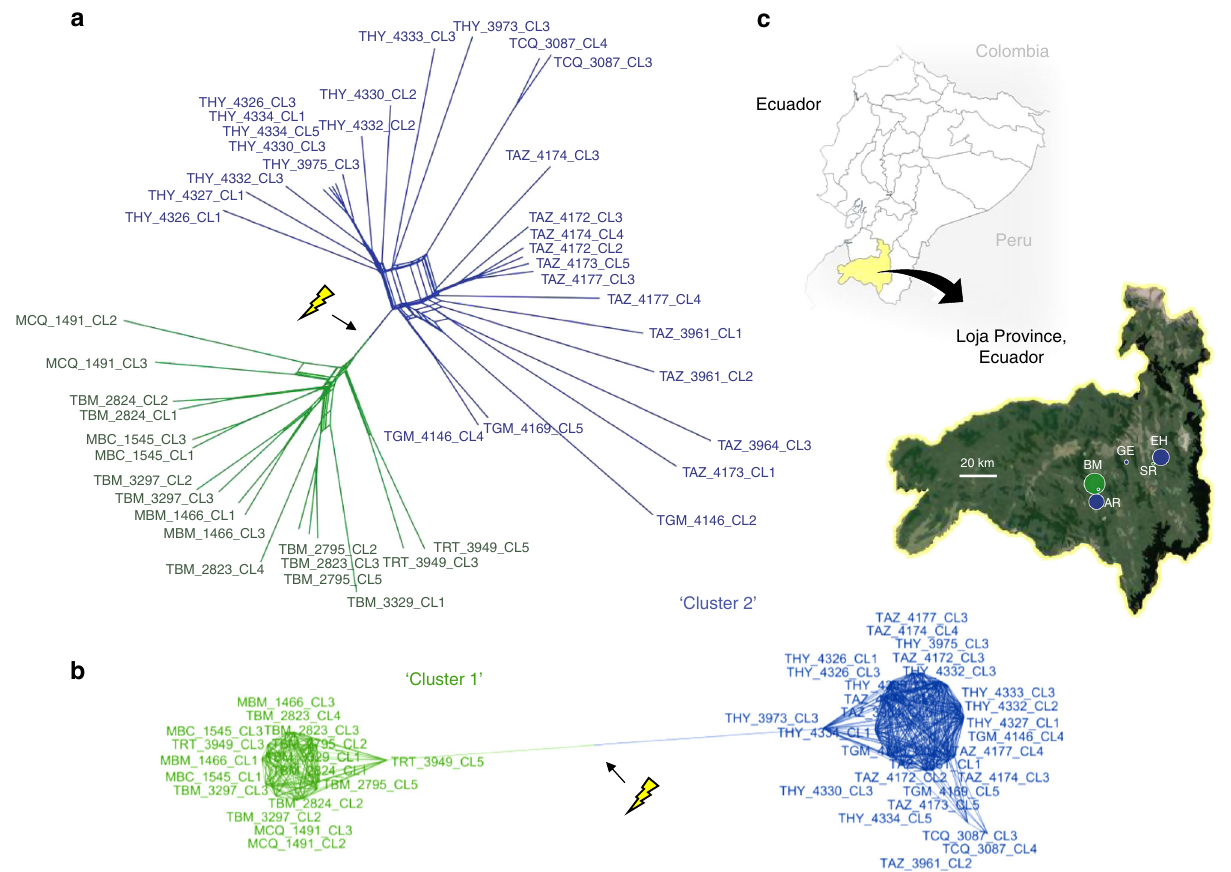
Fig. 1 Phylogenomic relationships among T. cruzi I clones from southern Ecuador. a Data are represented as a split network by the Neighbor-Net algorithm 68 . Pairwise genetic distances are de fi ned as the proportion of non-shared genotypes across all biallelic SNP sites for which genotypes are called in >40 individuals ( n = 68,449). Arrow (and fl ash) indicate a strong, unambiguous break in gene- fl ow between two reticulate assemblages, Cluster 1 (green) and Cluster 2 (blue). Though non-treelike phylogenetic models are better suited to the data, a maximum-likelihood tree is also provided for comparison in Supplementary Fig. 1. b A minimum-spanning network 80 further illustrates the genetic disconnectivity between Clusters 1 and 2. Multi-furcating nodes are arranged such that cumulative edge distance is minimized among samples. Pairwise genetic distances are haplotype- based, de fi ned as the proportion of non-shared alleles across all SNP sites for which genotypes are called for all individuals ( n = 7,392). c Sampling regions in Loja Province, Ecuador, are abbreviated as BM Bella Maria, AR Ardanza, EH El Huayco, SR Santa Rita, and GE Gerinoma. Point sizes correspond to sample sizes and colors correspond to cluster membership (see phylogenetic networks). The upper map is adapted from https://d-maps. com/carte.php?num_car = 3400&lang = en (d-maps.com). The close-up uses Landsat imagery courtesy of the U.S. Geological